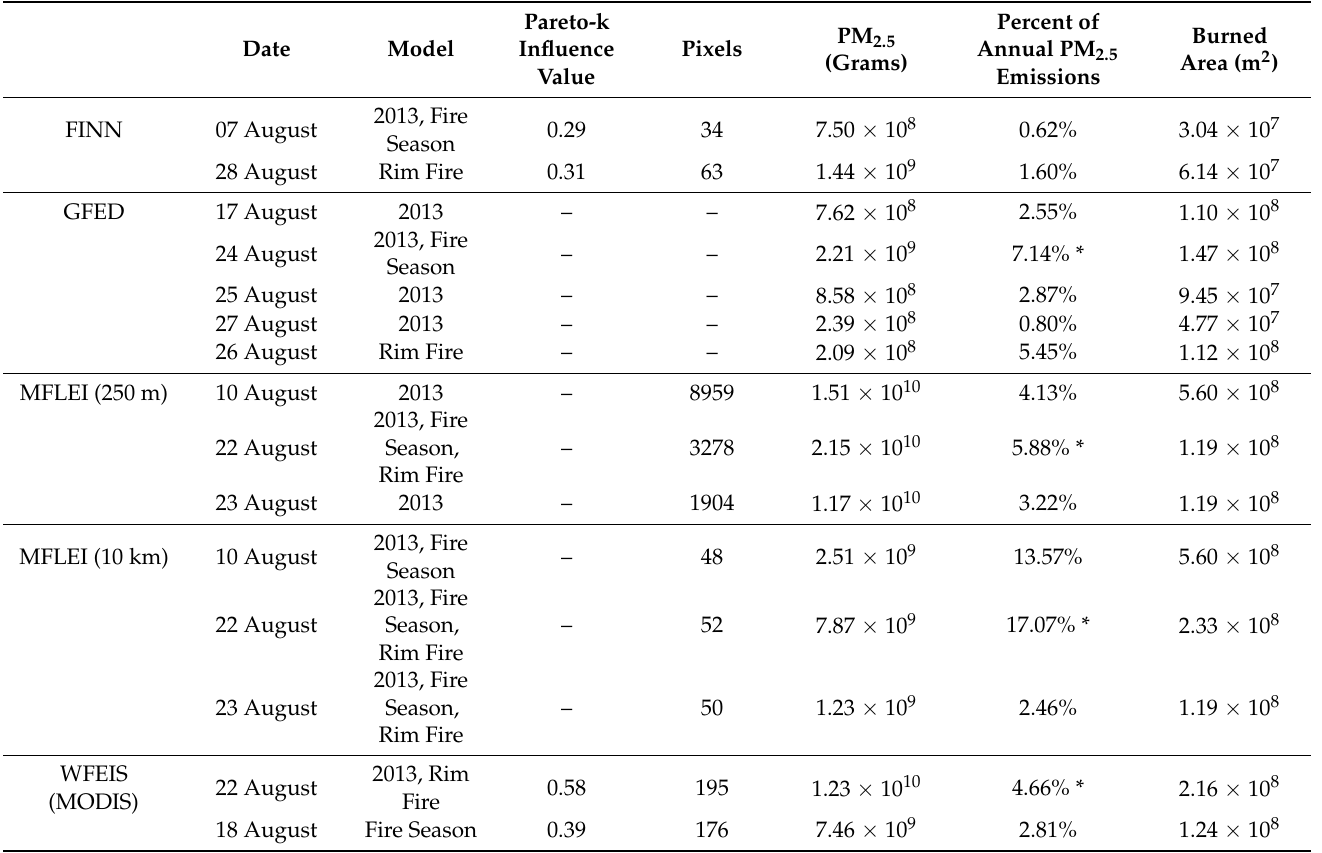
Table 3. Dates corresponding to the influential points for each fire emissions inventory Bayesian model (2013, fire season, and Rim Fire) and the number of fire pixels, PM 2.5 emissions (grams), and burned area (m 2 ) for each point. The percentage of annual emissions emitted on each day is also provided. An asterisk denotes the maximum percentage of annual emissions emitted. The Pareto-k influence value is only presented for points that were not outliers. Note: GFED does not provide pixel information for each